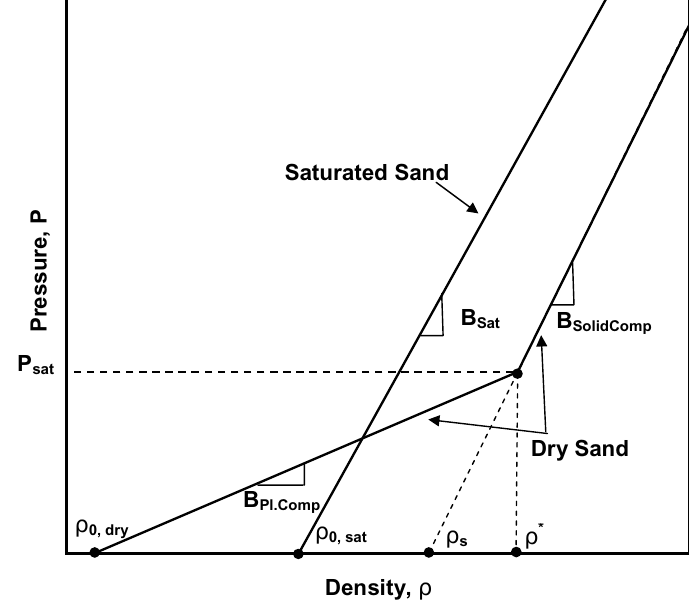
Fig. 2. A schematic of pressure vs. density relations for the dry and saturated